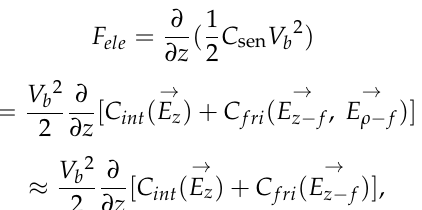
( b ) Figure 1 . Schematic views and images of a capacitive MEMS acoustic sensor fabricated with a TiN/Al/TiN diaphragm: ( a ) top view; ( b ) cross section diagram and a SEM image.